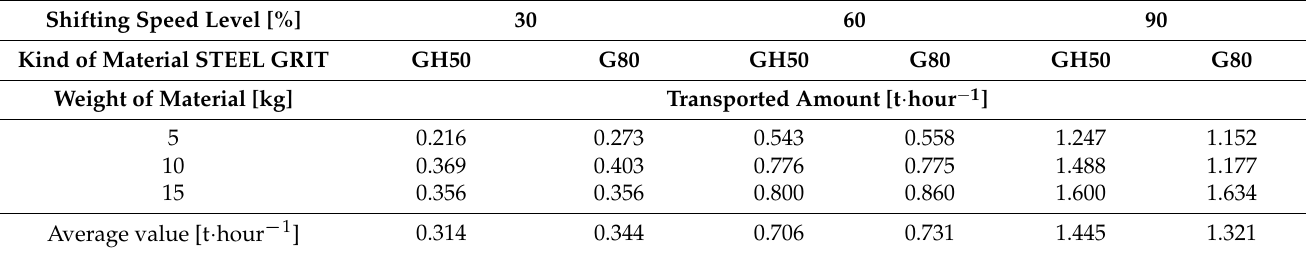
Table 3. Transported amounts of the steel abrasive materials, STEEL GRIT GH50 and GH80, for the stable transport area. Shifting Speed Level